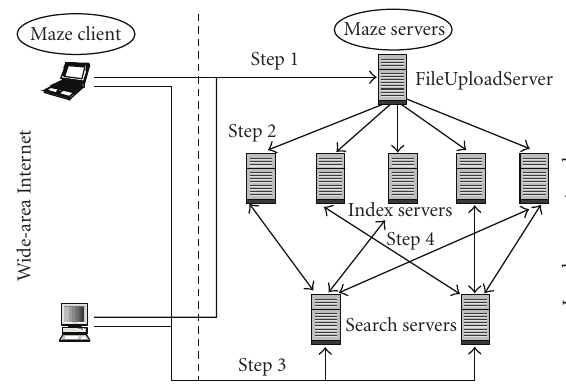
Figure 8: Architecture of the Maze file-sharing